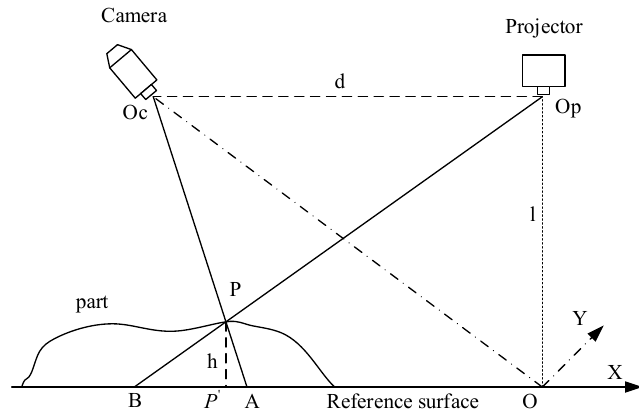
Figure 12. The optical path diagram of 3D structured light system.